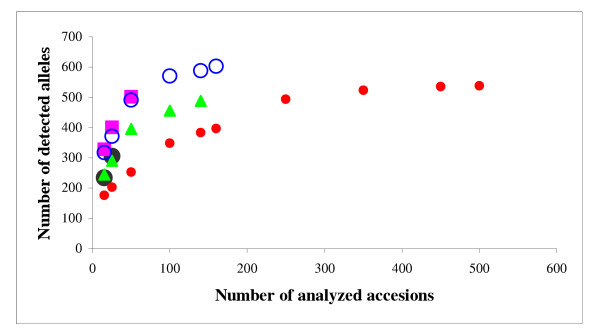
Dynamics of the allelic richness in dependence on the number of investigated accessions. The curves represent:  – Near East,  – Asia,  – Africa,  – America,  – Europe.